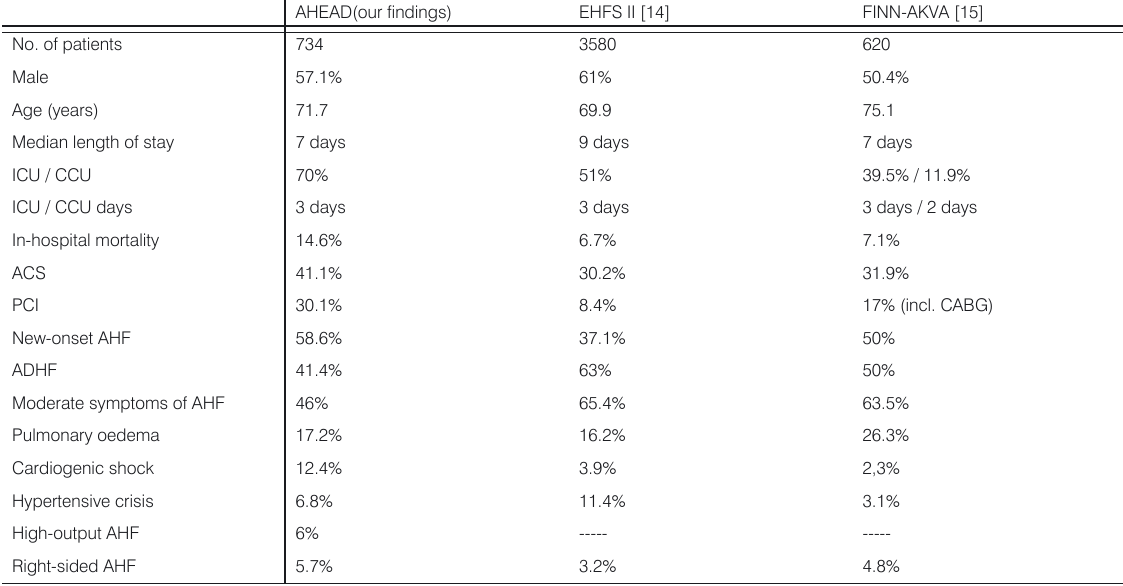
Table 5. The comparison with findings from selected